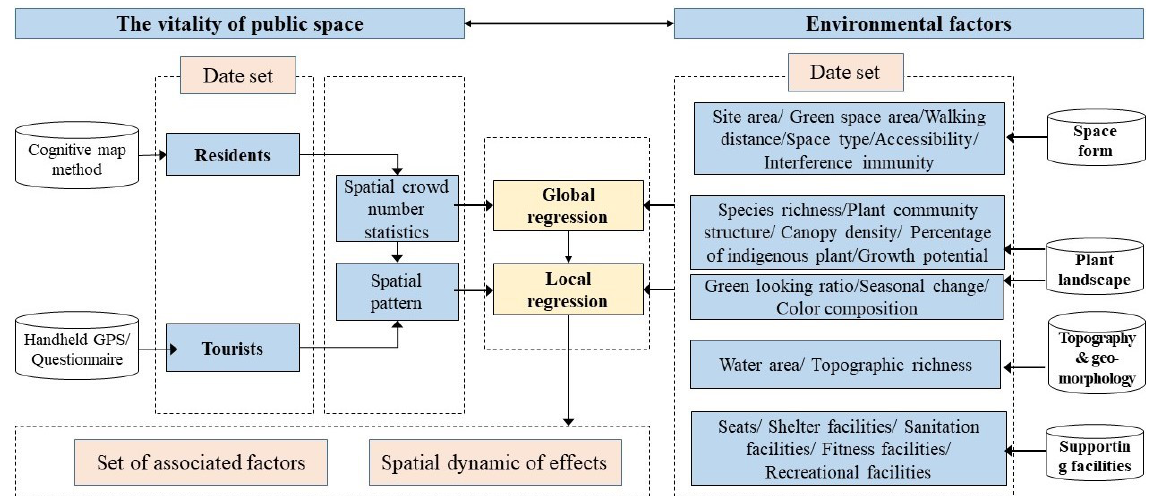
Figure 3. . Figure 3. Analysis